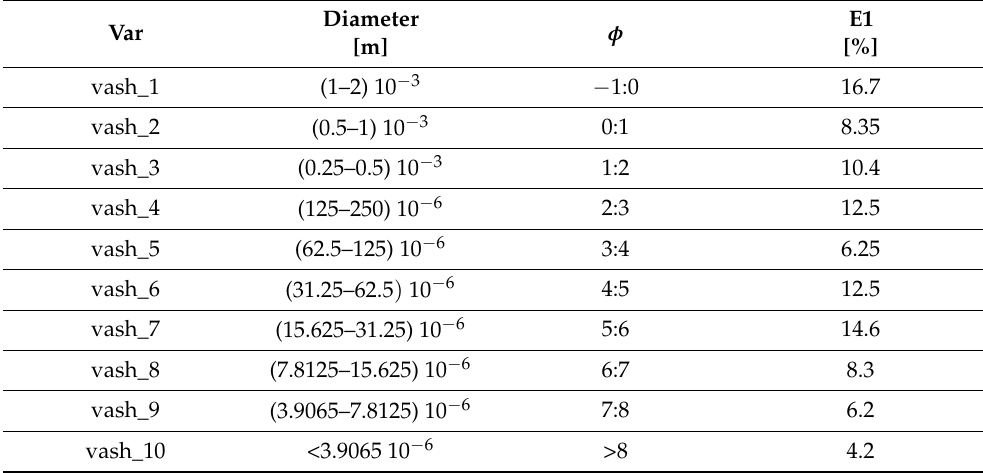
Table 1. Ash particle bin size diameter with corresponding WRF-Chem variable name, modes ( φ ), and the mass fractions in percent of total mass recalculated from Poret et al. [4]. Var